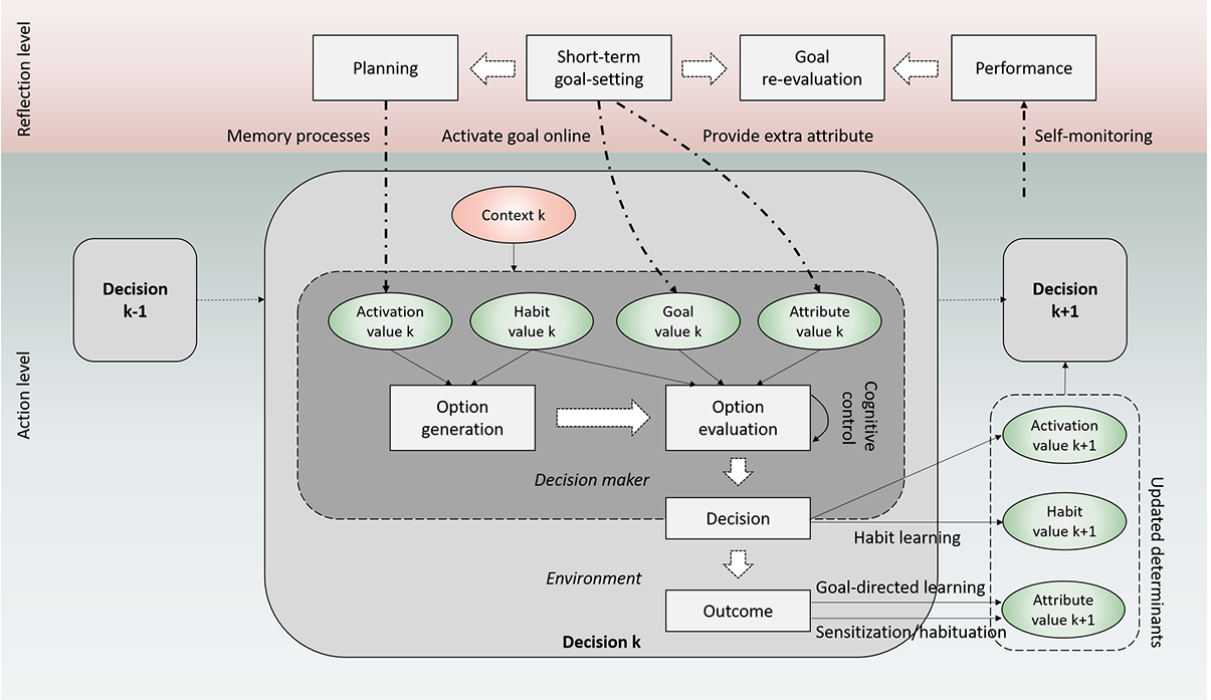
Figure 5. A full representation of the adaptive decision-making framework (reflection-level processes and interactions between the 2 levels added to the previous decision-making